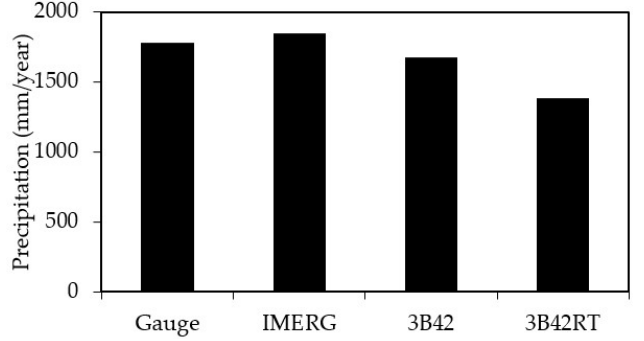
Figure 2. Total annual precipitation measured from gauges IMERG, 3B42 and 3B42RT in